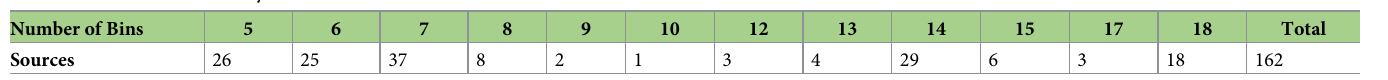
Table 2. Number of sources by bin